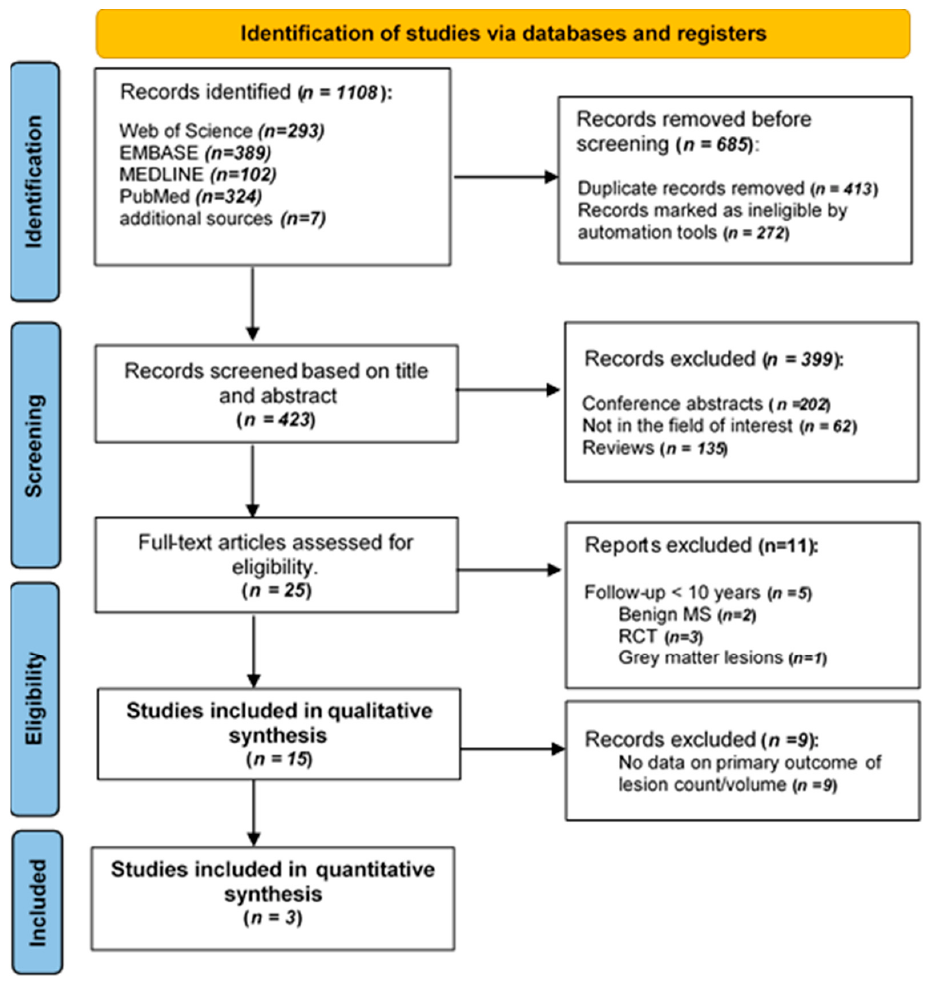
Figure 1. PRISMA flow diagram, illustrating the systematic search strategy and study selection.